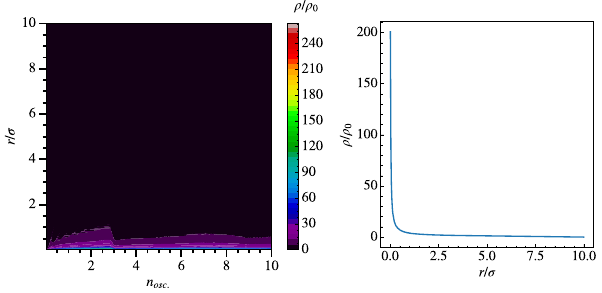
FIG. 22. MDM molecule density as a function of the radius and time (left) and the end time-averaged local molecule density versus radius (right). The molecule density is normalized with respect to the initial (or space-averaged) molecule density. In this simulation, the molecules are at a low temperature of T=T (cid:3) ¼ 10 − 5 , and the particles initially distributed throughout μ the transverse x - y space.